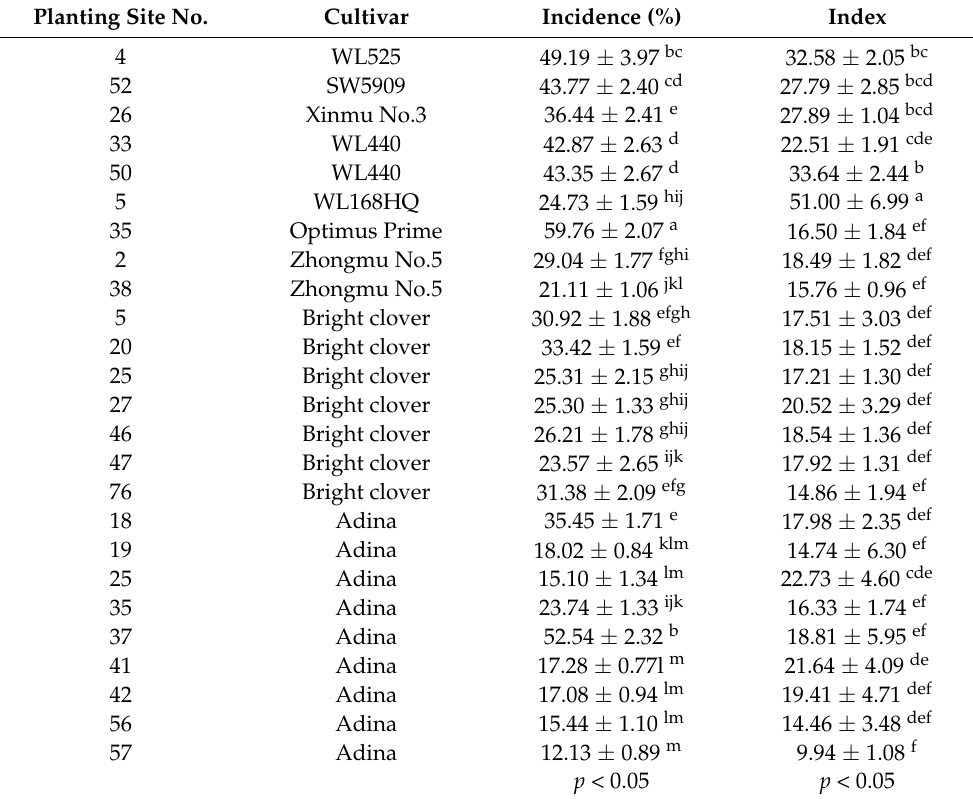
Table 2. The incidence and disease index of alfalfa Leptosphaerulina leaf spot. Planting Site